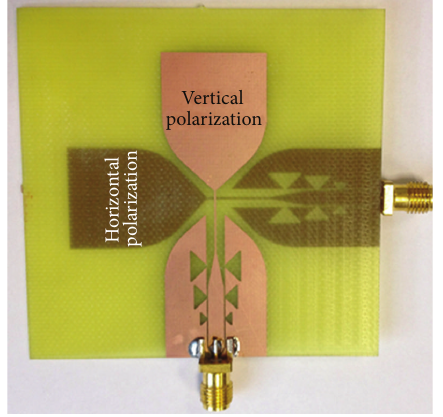
Figure 5: Prototype of the proposed